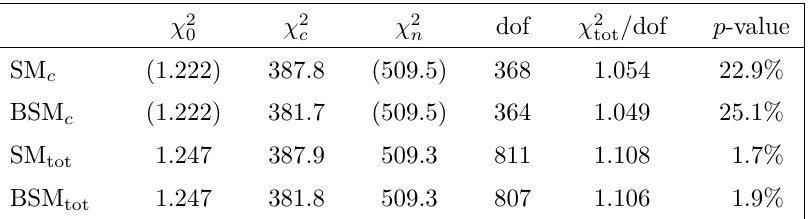
Table 1 . Summary of the four considered fit scenarios: SM c (exclusive, C -conserving), BSM c (exclusive, C -violating), SM (combined, C -conserving), BSM (combined, C -violating). For fits tot tot obtained by dropping the contributions of χ 2 and χ 2 to the total discrepancy function χ 2 , their n tot 0 values are put in brackets. All values refer to fit results of our central solution. α β · M 2 γ · M 2 π π — — — — BSM 0 . 92(4) − 0 . 027(3) 0 . 095(4) 0 . 015(17) tot Table 2 . Results for the subtraction constants of the SM amplitude in the first row and the full BSM representation in the second row for the fit scenarios SM and BSM . tot tot respectively, we find a minor improvement of χ 2 by about 1 . 6% , whereas χ 2 and χ 2 c n 0